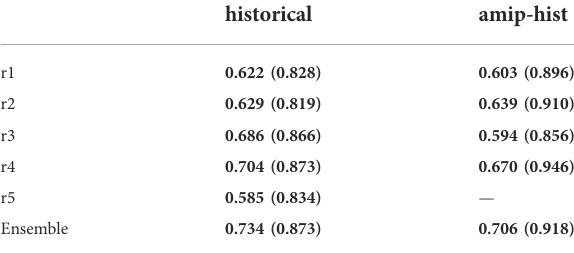
TABLE 4 Correlation coef fi cients of annual mean SATA (11-year running average in brackets) between CRUTEM4 and coupled and uncoupled simulations from 1870 to 2014 (values in bold are signi fi cant at the 95%